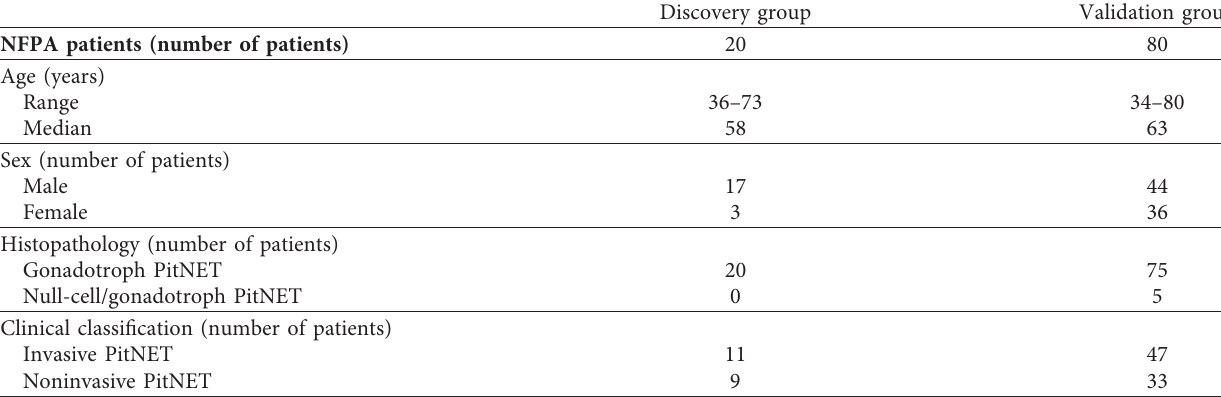
Table 1: Patients’